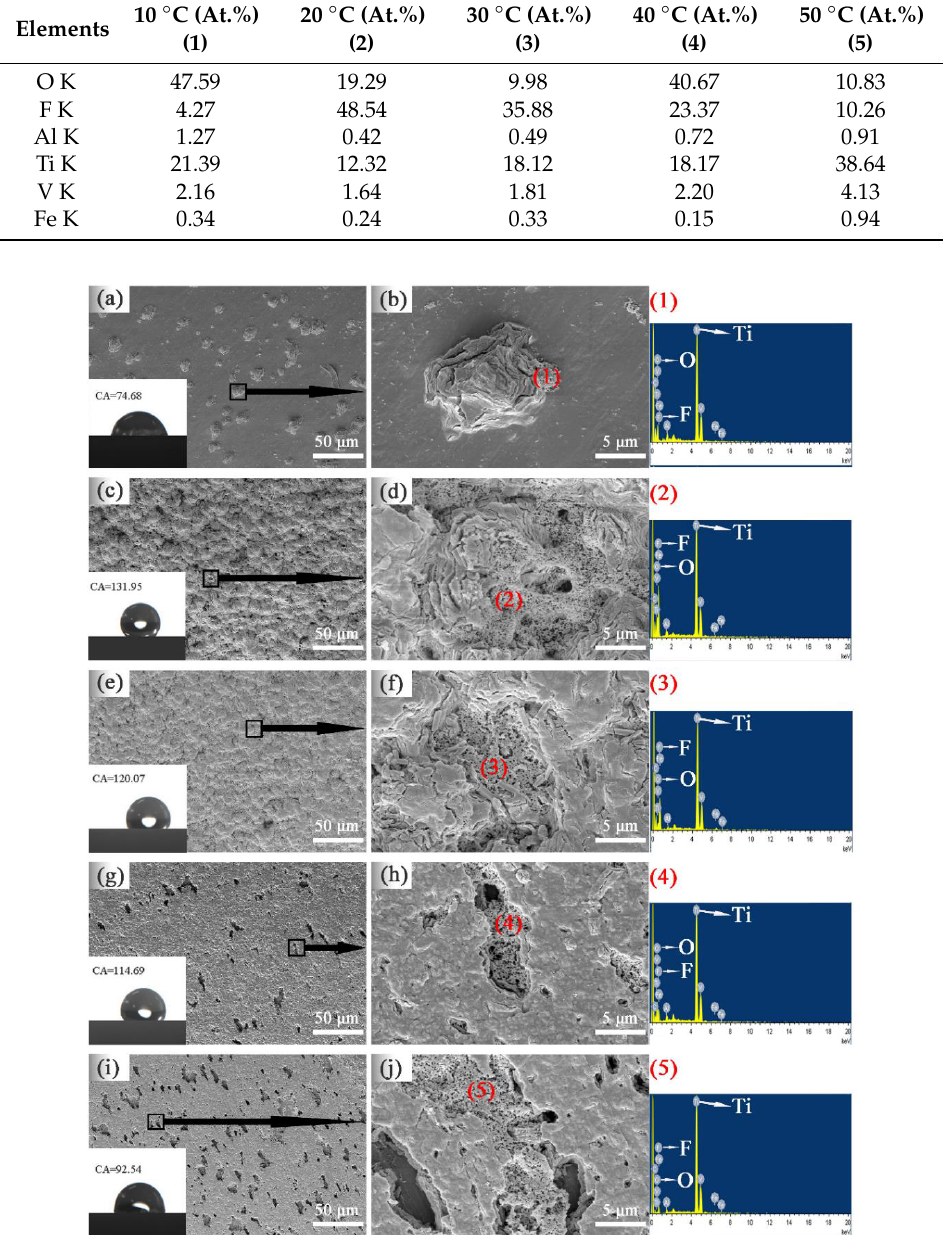
Figure 2. FE-SEM images and the corresponding EDS, contact angles (Cas) of composite anodic films fabricated at different temperatures: ( a , b ) ( 1 ) 10 °C; ( c , d ) ( 2 ) 20 °C; ( e , f ) ( 3 ) 30 °C; ( g , h ) ( 4 ) 40 °C; ( i , j ) ( 5 ) 50 °C.